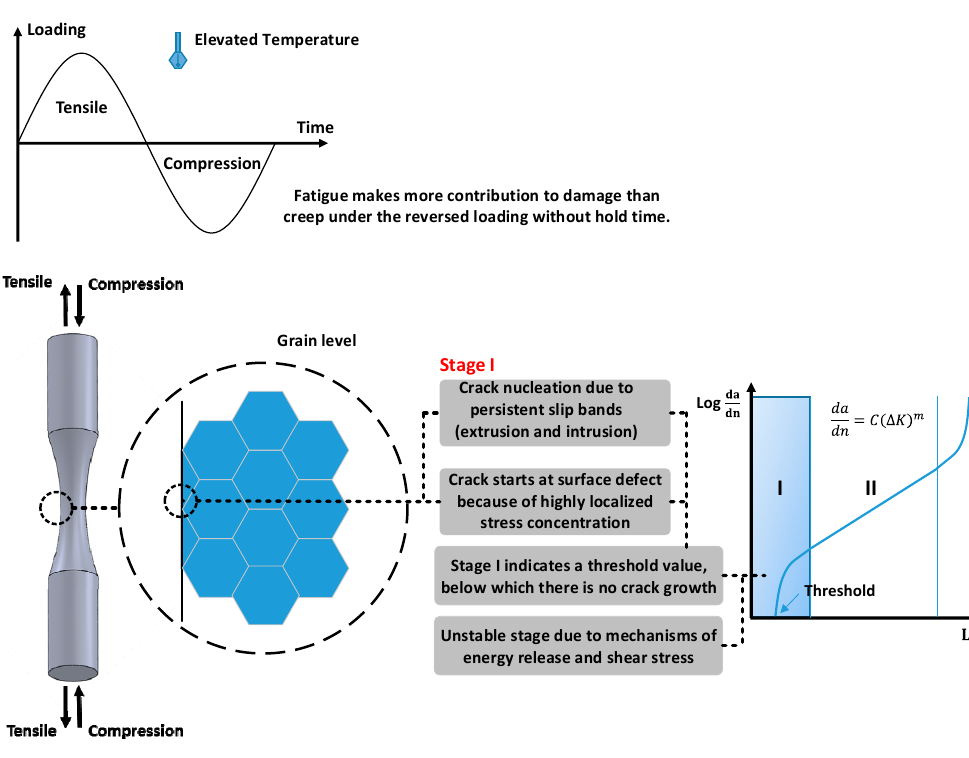
Figure 5. Key elements (mechanisms) in the crack initial stage. Metals 2018 , 8 , x FOR PEER REVIEW